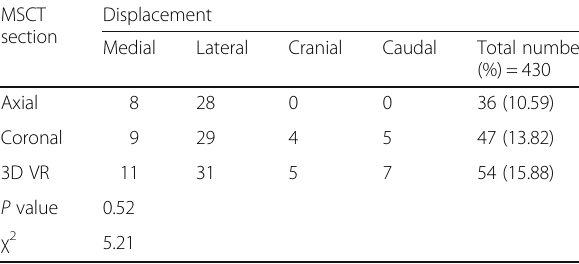
Table 3 Distribution of misplaced screws according to CT